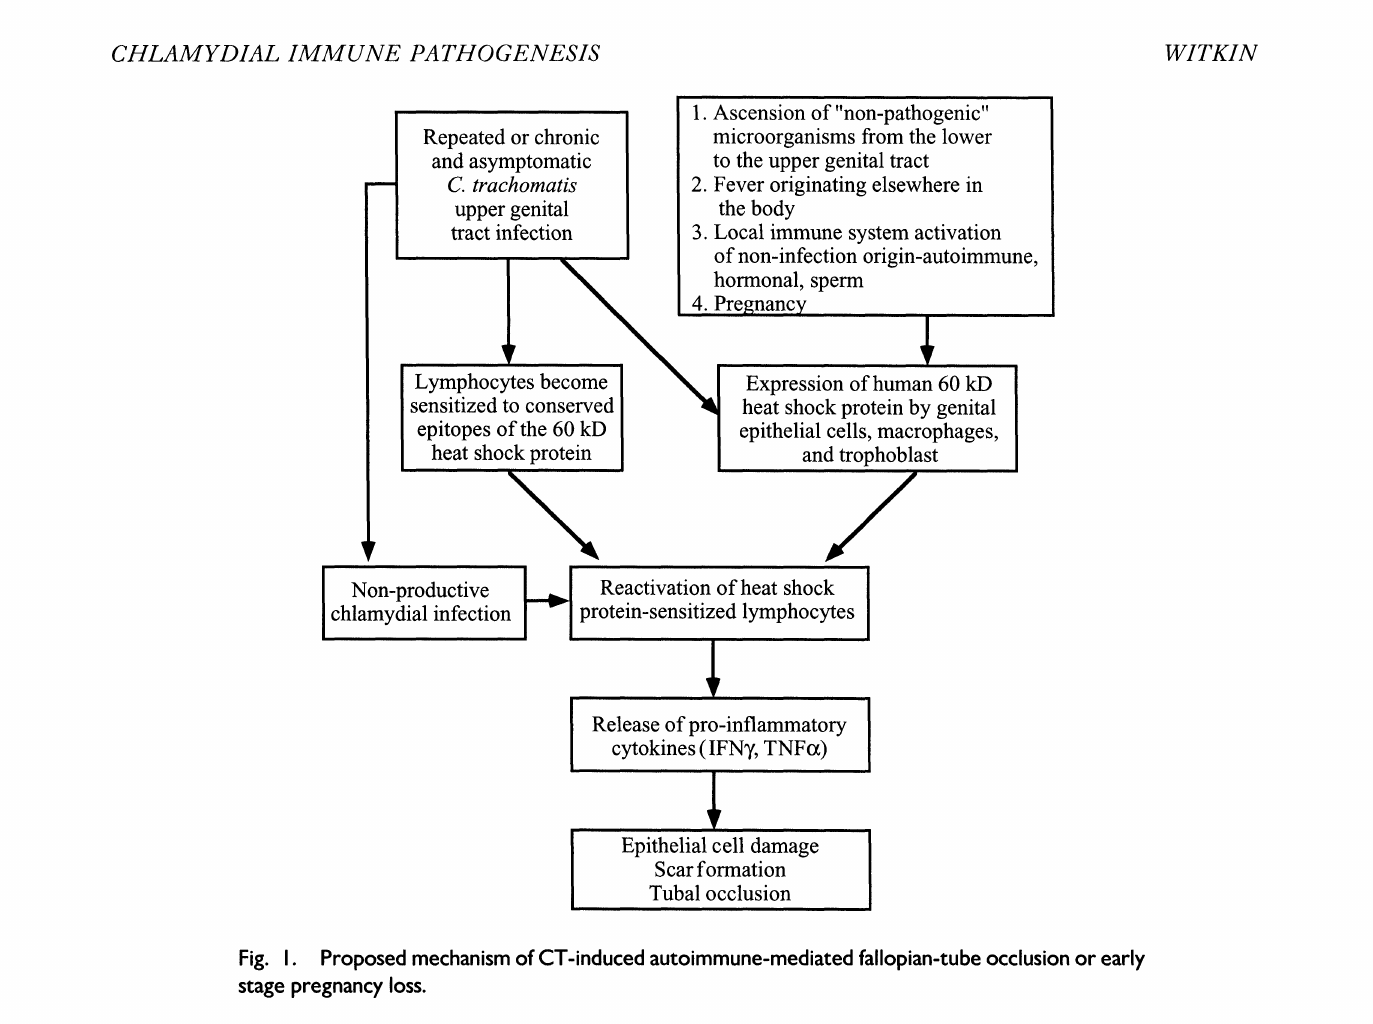
Fig. I. Proposed mechanism of CT-induced autoimmune-mediated fallopian-tube occlusion or early stage pregnancy